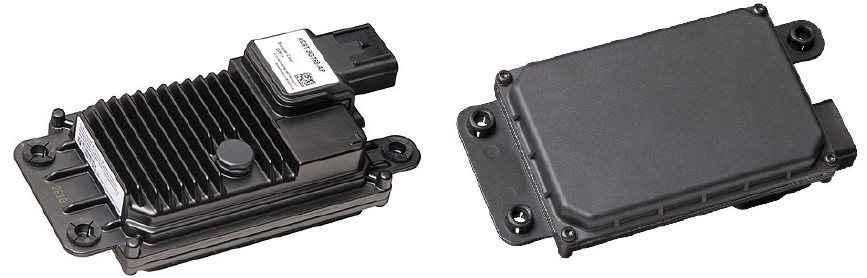
Figure 1. Delphi Electronically Scanning Radar (ESR) Platform. Table 1. Specification of ESR Radar.